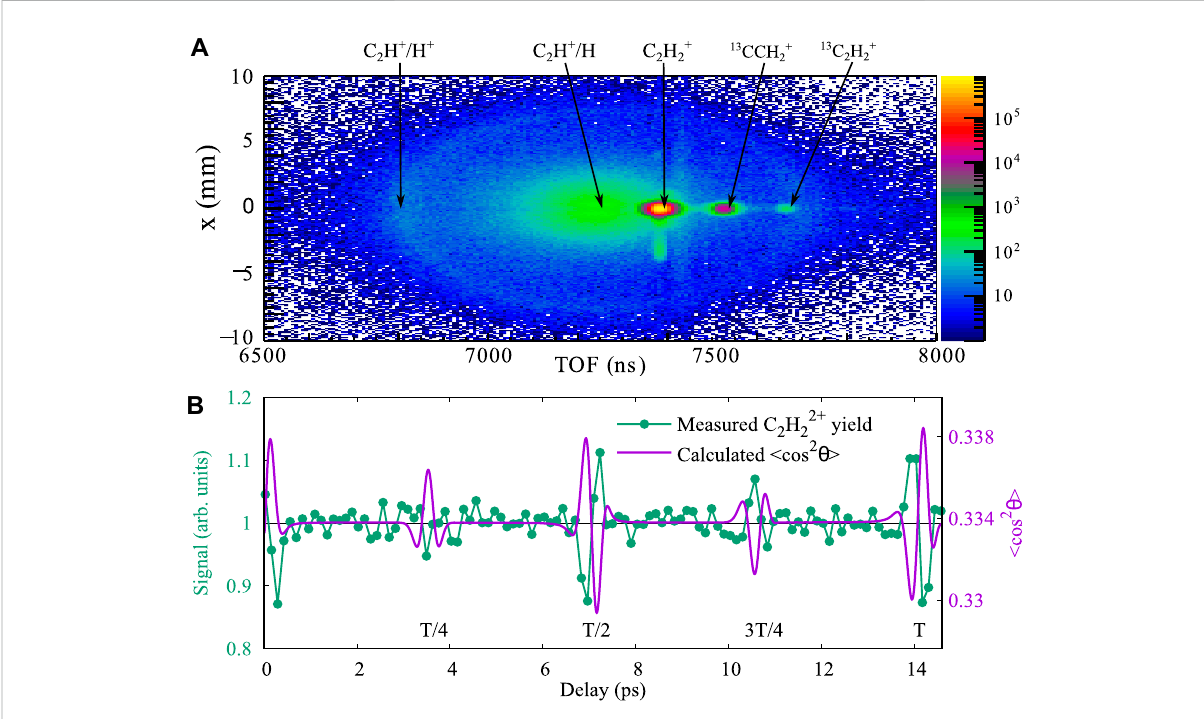
FIGURE 1 (A) Measuredioncountdistributionoverthetime-of- fl ightandxpositiononthedetector.Thepeakintensityofthelaser fi eldis4×10 14 W/cm 2 , and the pulse duration is 25 fs. (B) Measured C 2 H 2 + 2 signal and simulated < cos 2 θ > as a function of the time delay between the alignment and the ionization pulse. For the simulation, the gas temperature of 200 K and the peak intensity of 1 × 10 13 W/cm 2 of the alignment pulse are used.